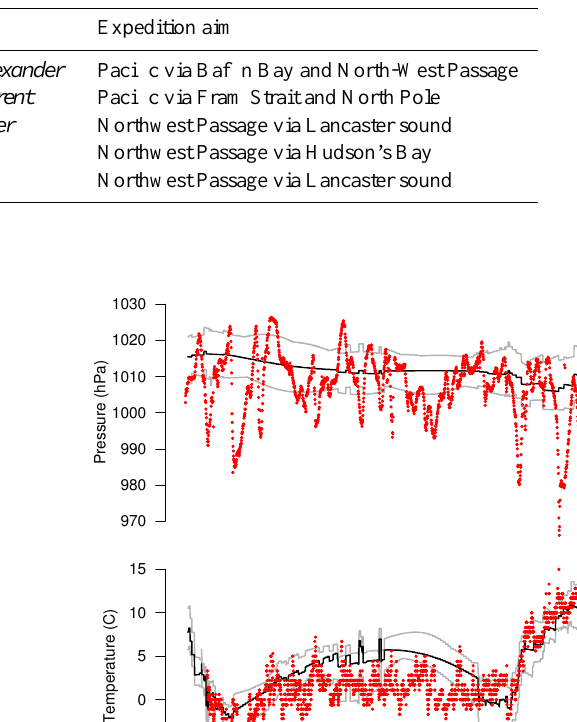
Fig.3. RoutesoftheRoyalNavyexpeditionsprovidingnewobservations. Filledcirclesmarkoverwinteringsites. Fig. 3. Routes of the Royal Navy expeditions providing new obser- vations. Filled circles mark overwintering sites.